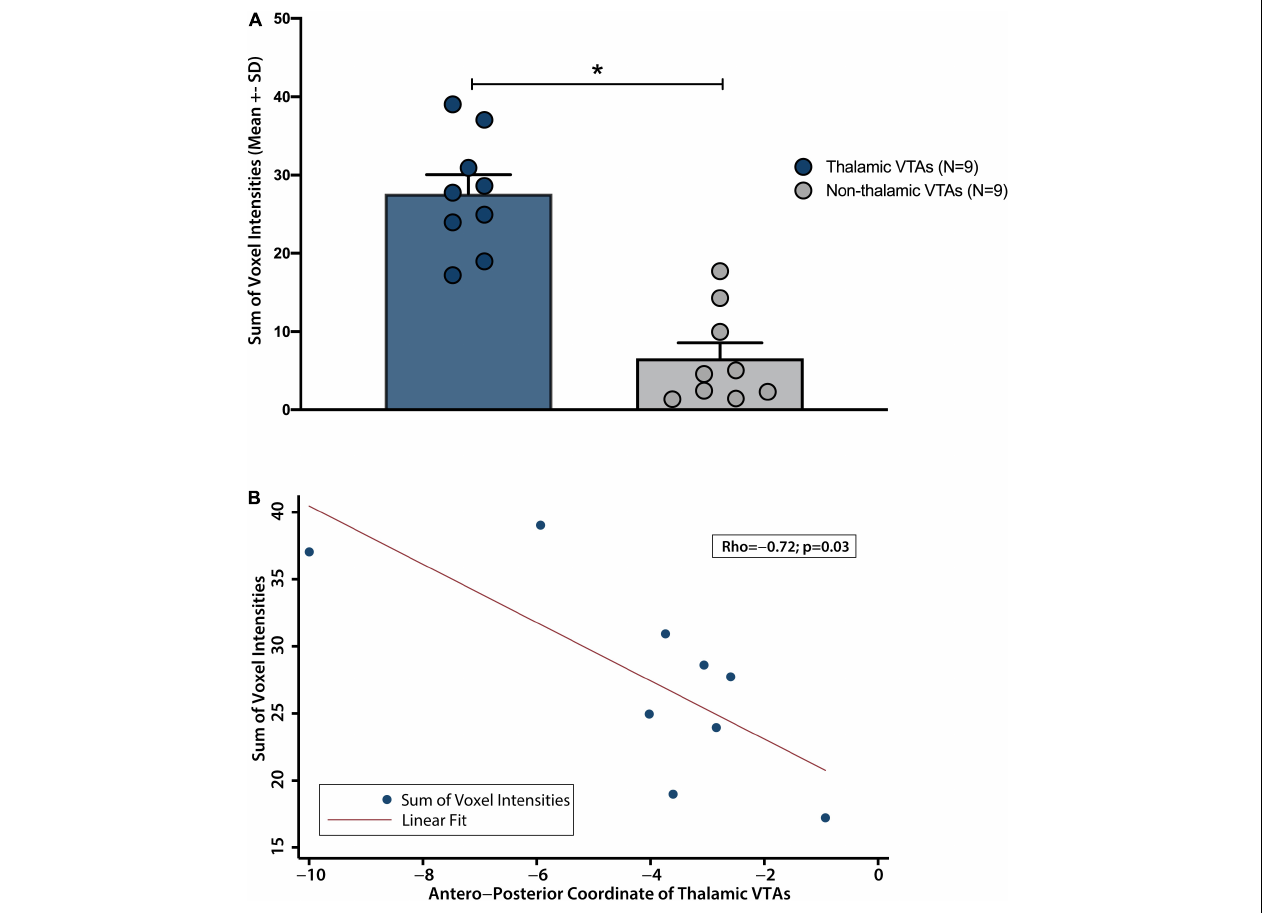
FIGURE 2 | Connectivity of VTAs with the spatial component of the previously descibed HT lesion network map. (A) Thalamic VTAs have a significantly higher connectivity with the spatial component of previously described HT lesion network map than non-thalamic VTAs. (B) Connectivity varied significantly along thalamic antero-posterior axis. * p <